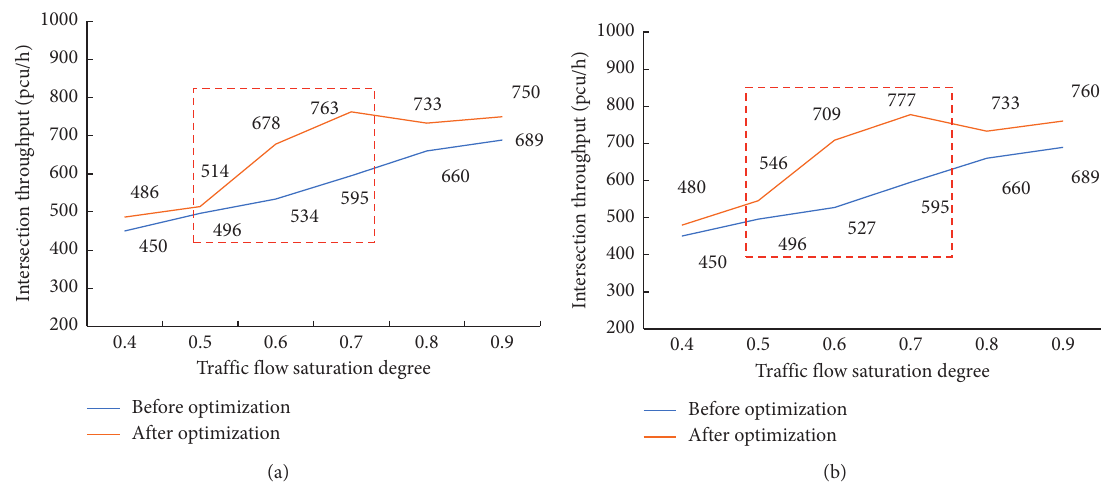
Figure 5: Intersection throughput before and after signal optimization in traffic incident. The incident occurs at (a) the approach road and (b) the departure